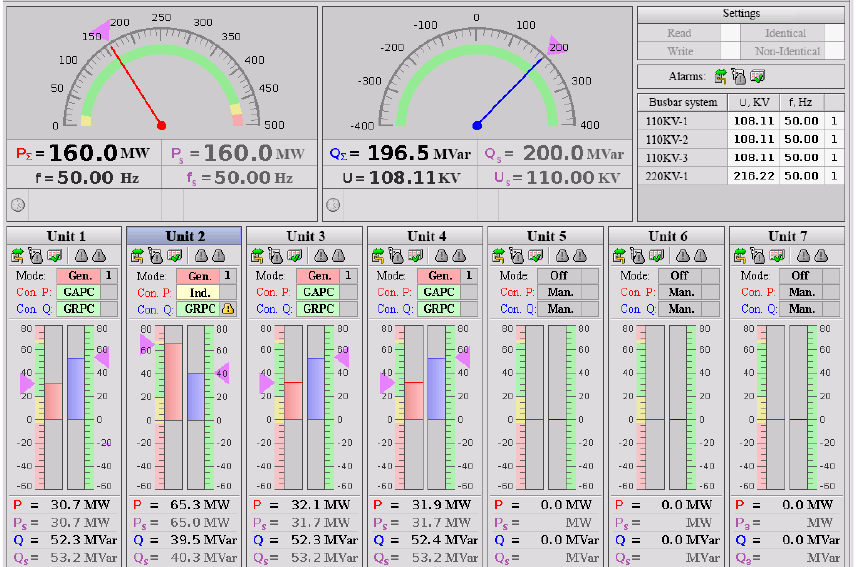
Figure 8. The main window of the digital AGC system: unit 2 has constraints on apparent power.